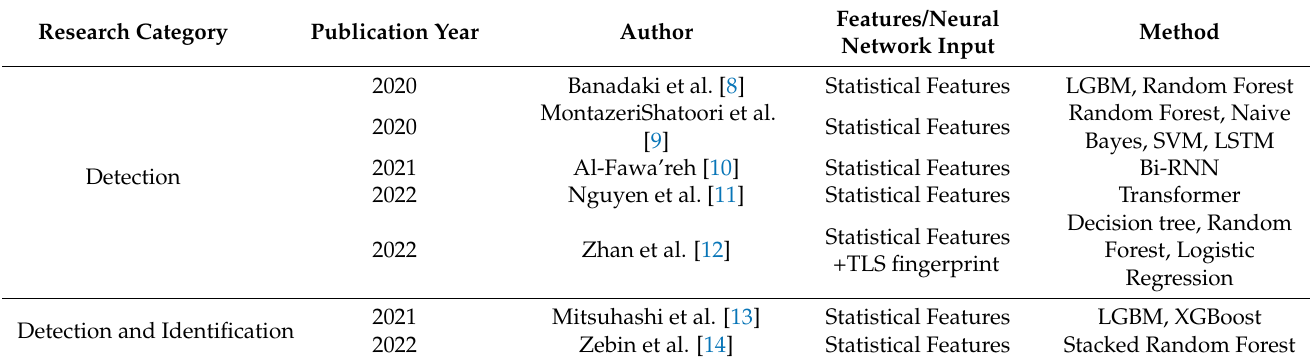
Table 1. Research on DoH-encrypted DNS covert channel detection and